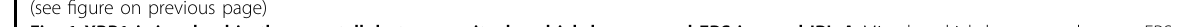
lenti-Xbp1 and 6.59 ± 0.71 in lenti-shRNA-Xbp1). Mean- while, the expression of P53, ATM, and cleavage caspase 3 were descended in XBP1 knockdown cells and enhanced in XBP1 overexpression cells as compared to control cells (Fig. 3B). Similarly, fl ow cytometric analysis revealed that the apoptotic cells were small reduced in XBP1 knockdown cells as compared to that in control cells (11.12 ± 0.86 % in